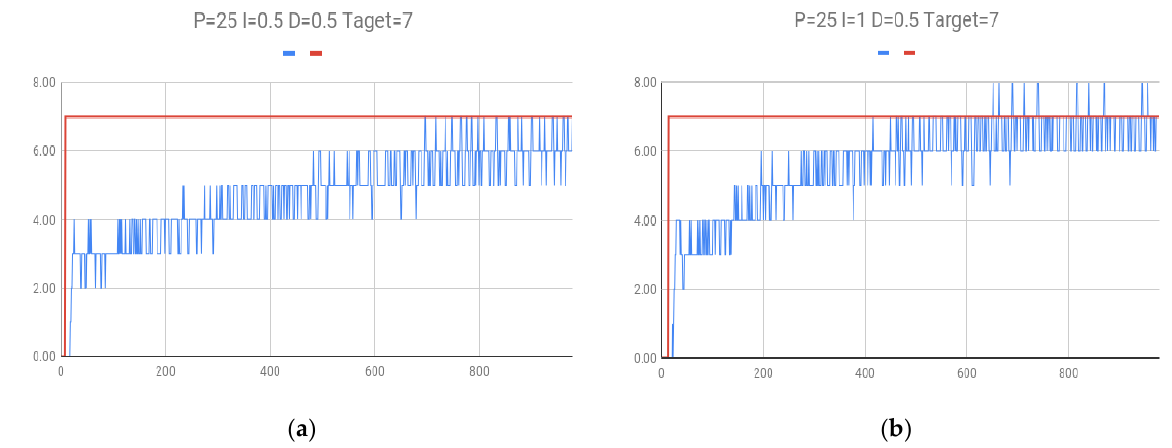
Figure 12. The dynamic behavior of the ventilation system for different PID settings for the Kp, Ki, and Kd parameters: ( a ) less aggressive ones; ( b ) more aggressive ones. and Kd parameters: ( a ) less aggressive ones; ( b ) more aggressive ones.